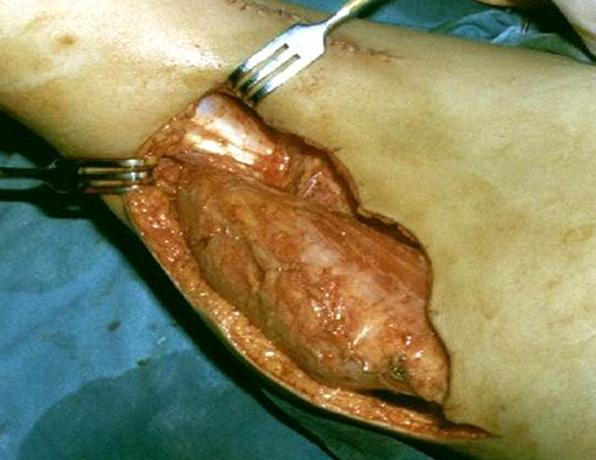
Tendon reinsertion. The conjoined tendon was transferred to the posterior deltoid incision and reinsertion of the conjoined tendon to humerus was achieved while the arm was at 90° abduction and full external rotation.